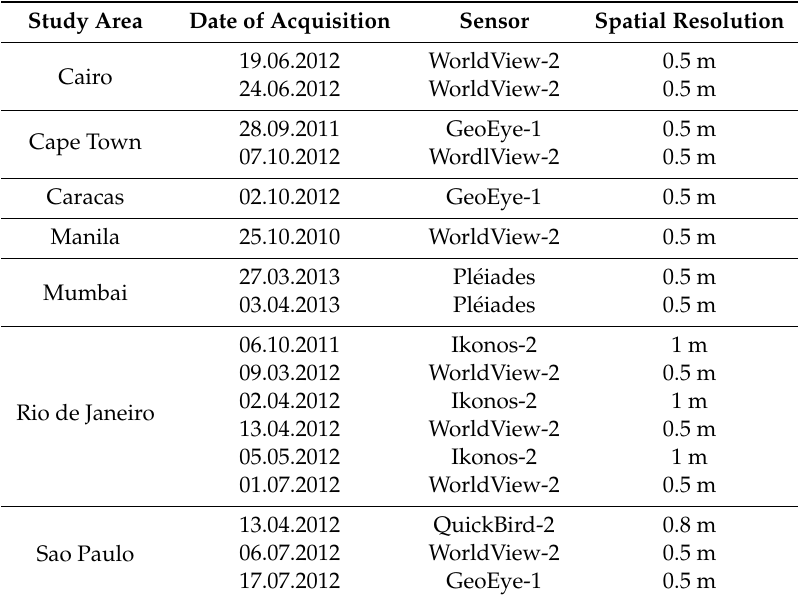
Table 2. Satellite data used for classification of morphological settlement